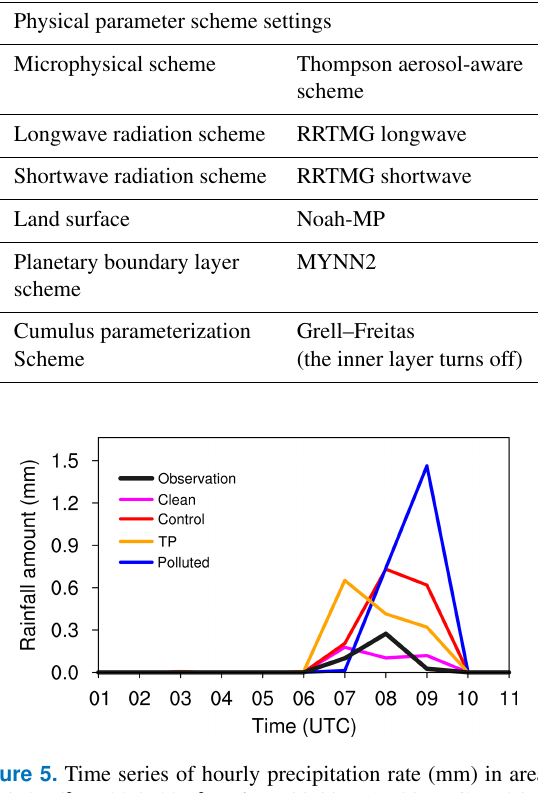
Table 3. Physical parameter scheme settings.